Question: Name the type of graph shown.
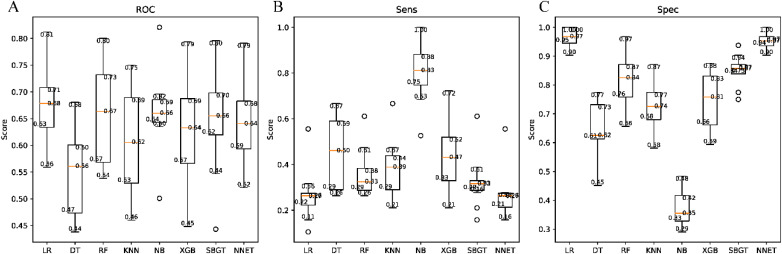
Answer: line